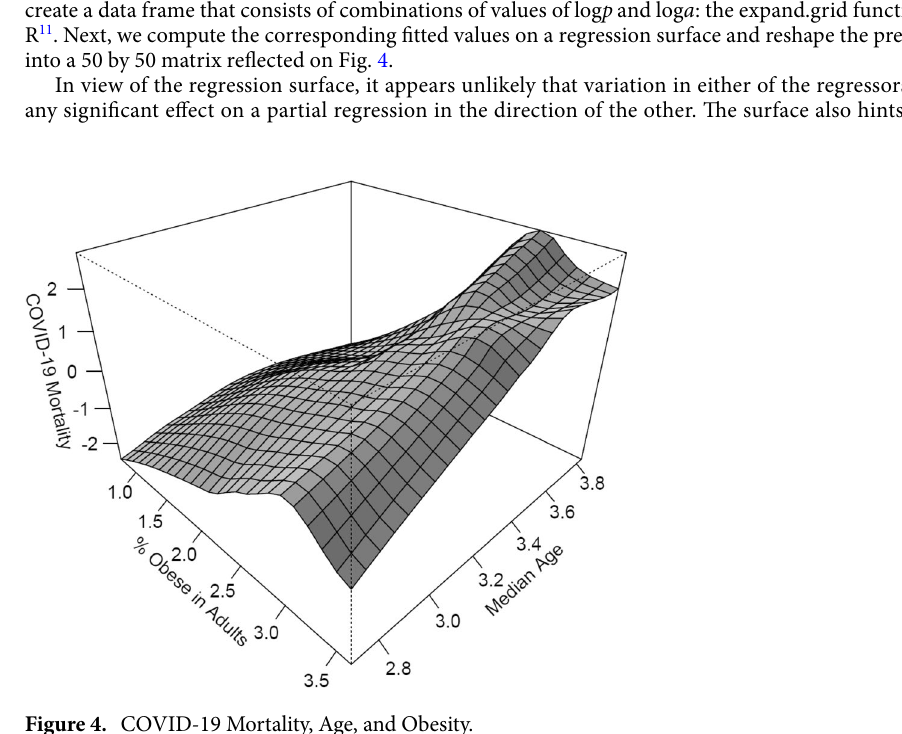
Figure 4. COVID-19 Mortality, Age, and